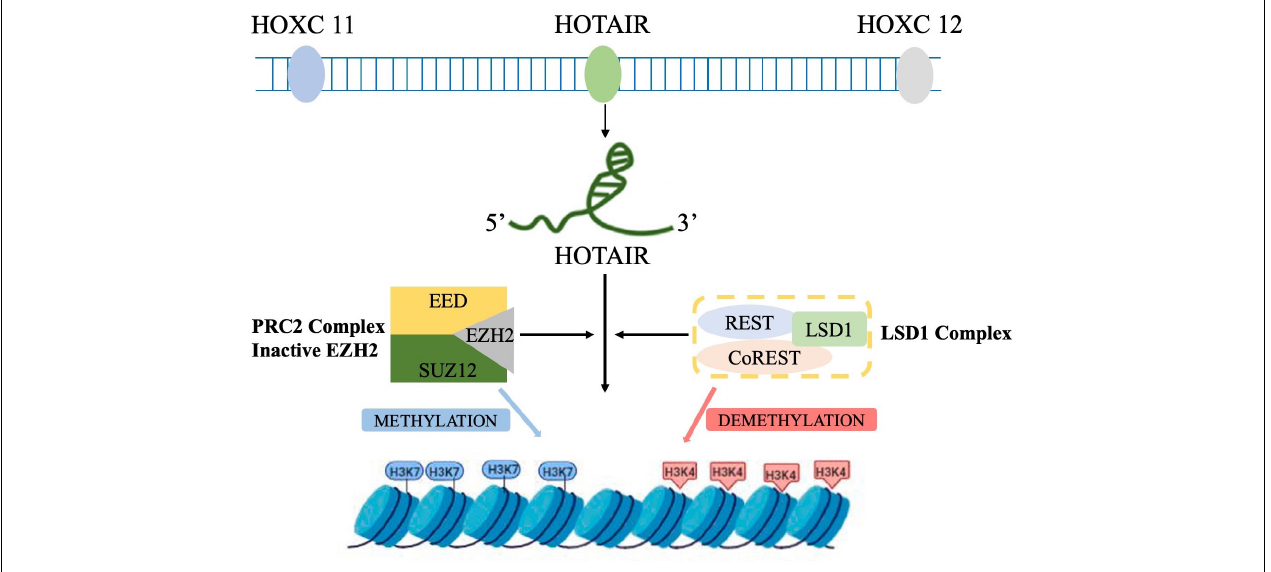
FIGURE 1 | Schematic representation of HOTAIR-mediated gene silencing. HOTAIR acts as a molecular scaffold, bridging PRC2 and LSD1 complexes and altering gene expression by promoting H3K27me3 and H3K4 demethylation (by PRC2 and LDS1, respectively) at the target